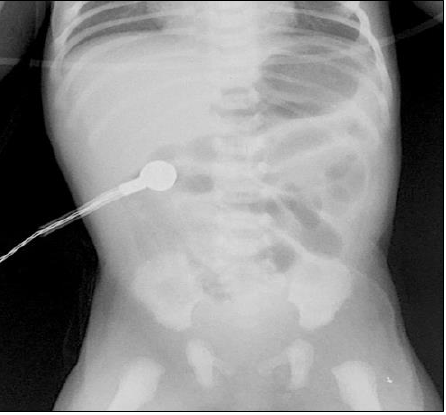
Figure 1: Abdominal radiograph showing dilated small bowel loops and absence of gas shadows in the pelvis.